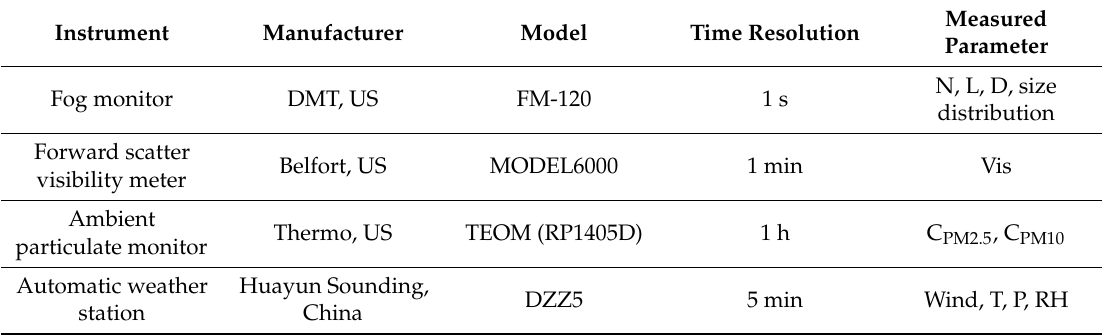
Table 1. Instrumentation and measurements for the winter fog observations in